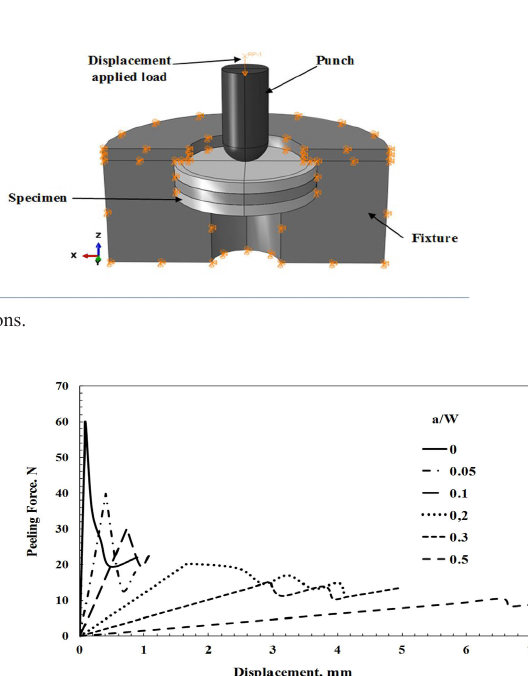
Figure 13. Effect of pre-crack on Al/CU/Al sandwich composites under peeling